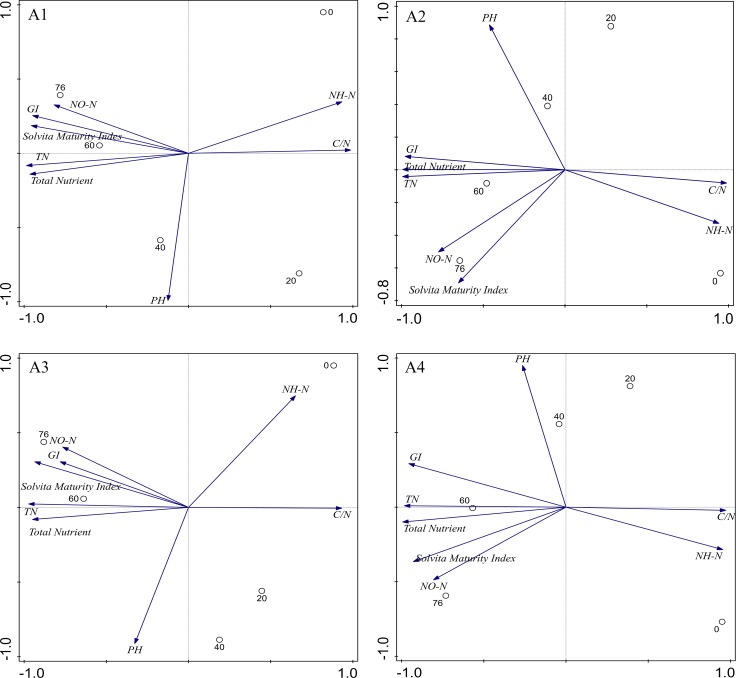
PCA analysis of the parameters in composting process.